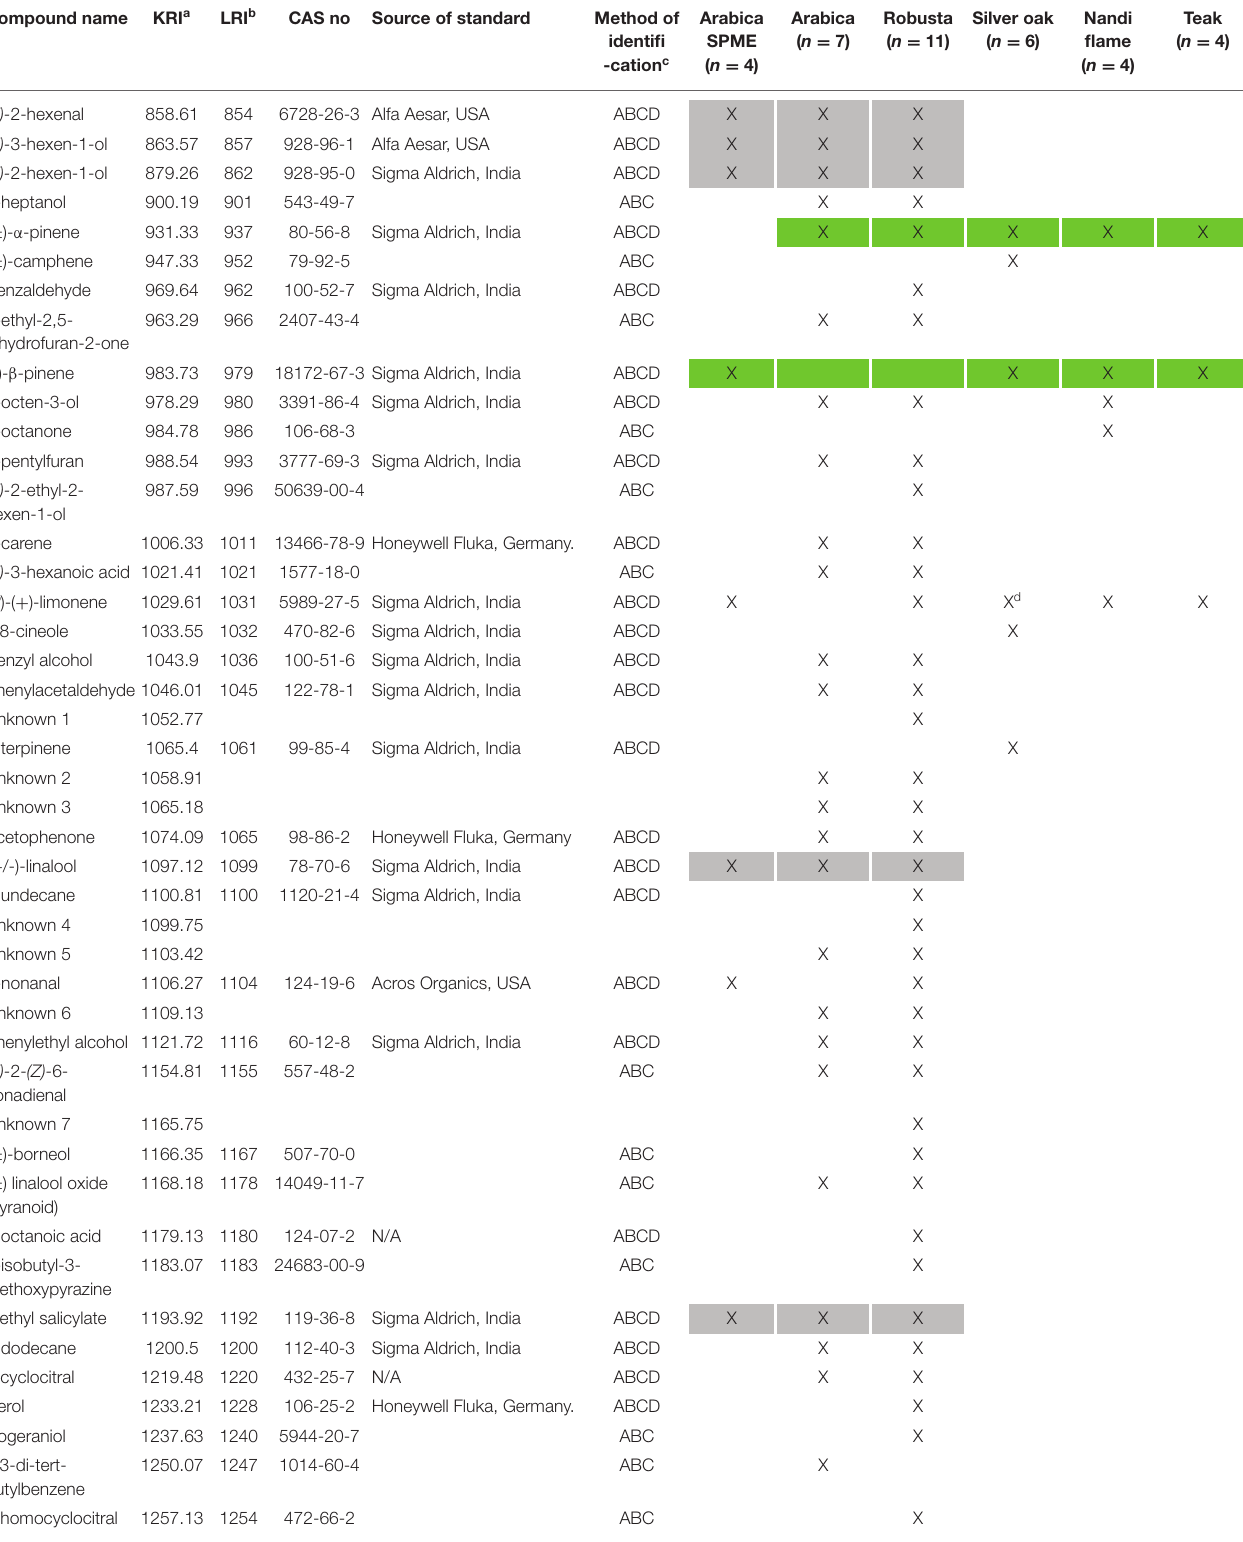
TABLE 1 | List of volatile compounds of arabica coffee (SPME), arabica coffee (Solvent extraction), robusta coffee (Solvent extraction), cut stems of silver oak, nandi flame and teak (SPME). Compound name KRI